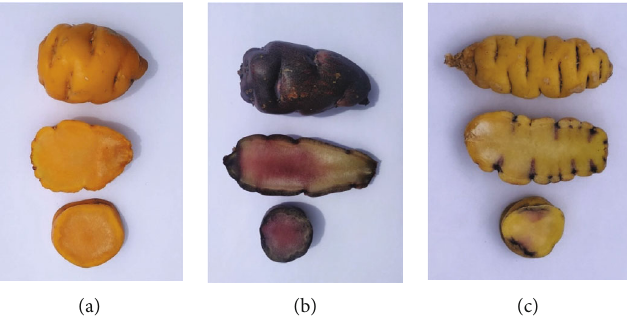
Figure 1: Genotypes of mashua tubers: (a) yellow, (b) purple, and (c)